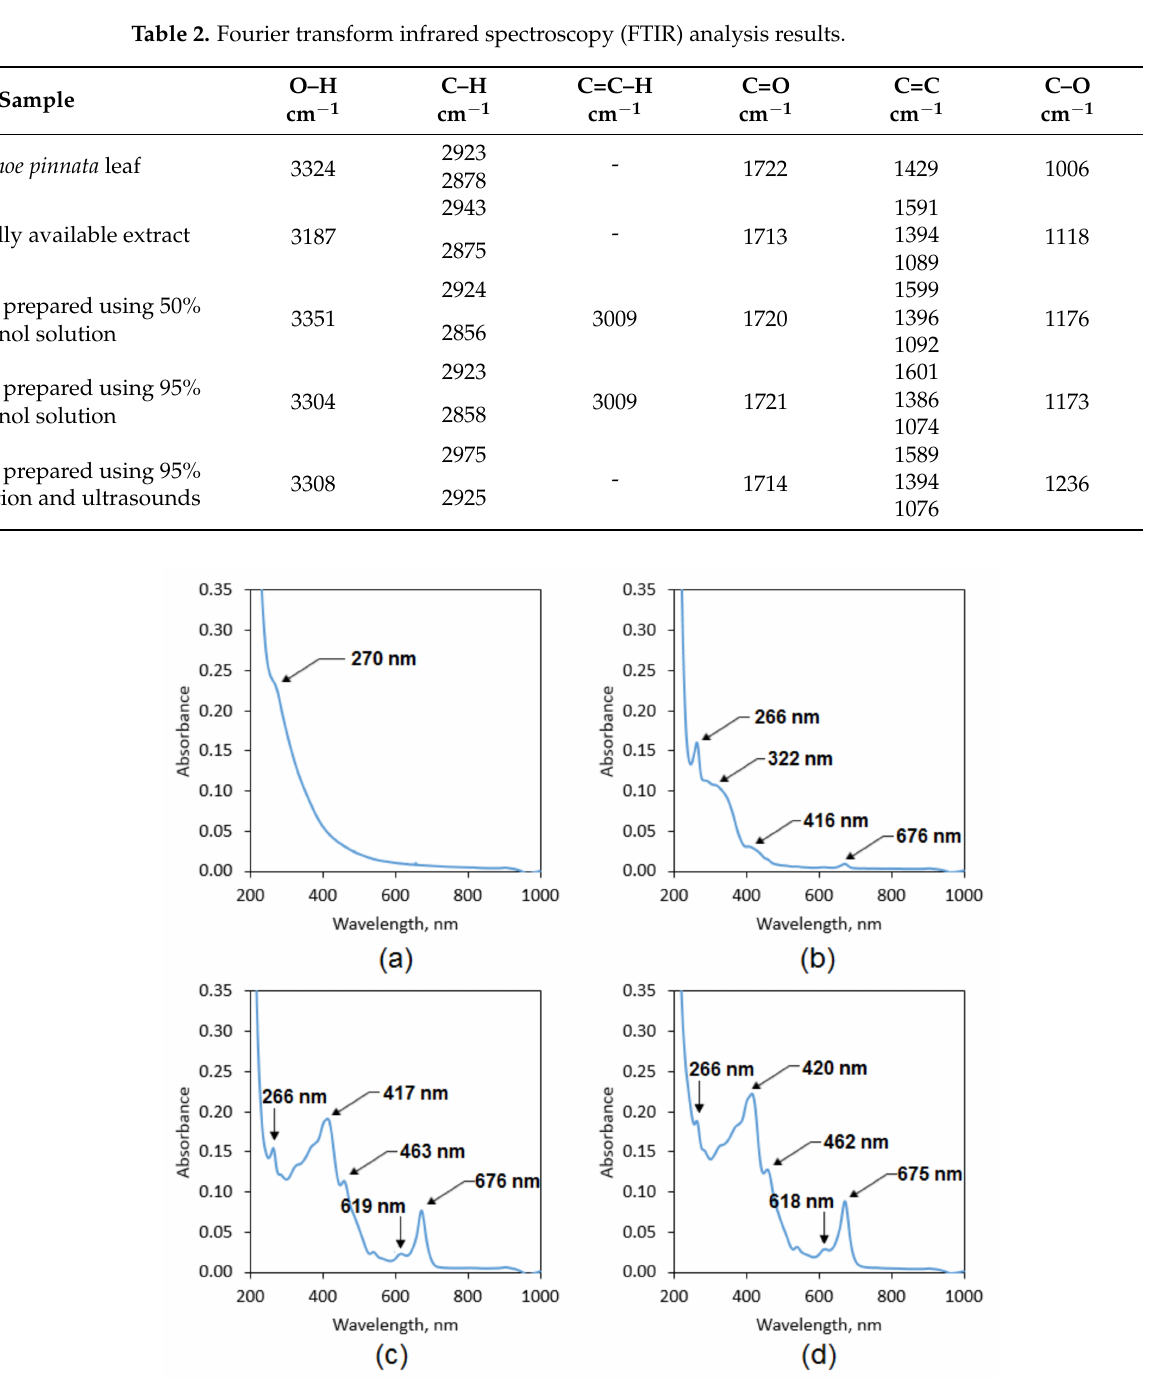
Figure 4. UV-Vis spectra of the natural extracts ( a ) commercially available extract; ( b ) plant